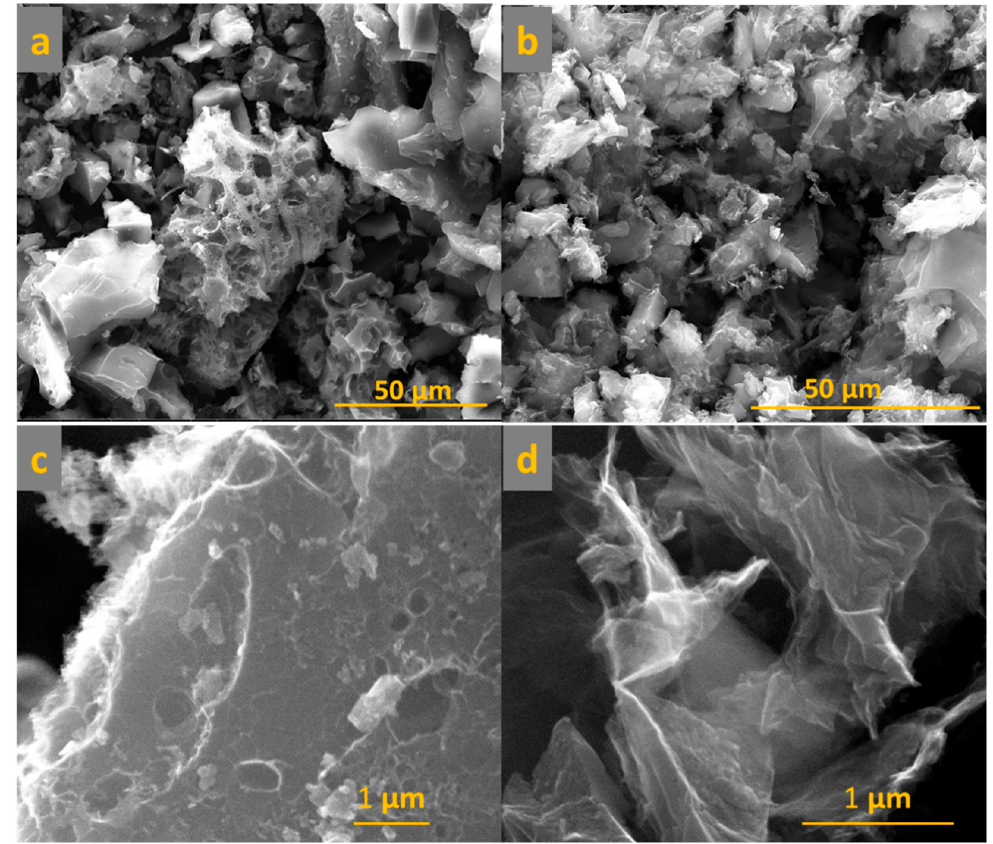
Figure 1. SEM images registered for WW ( a , c ) and rGO-WW ( b , d ) samples.